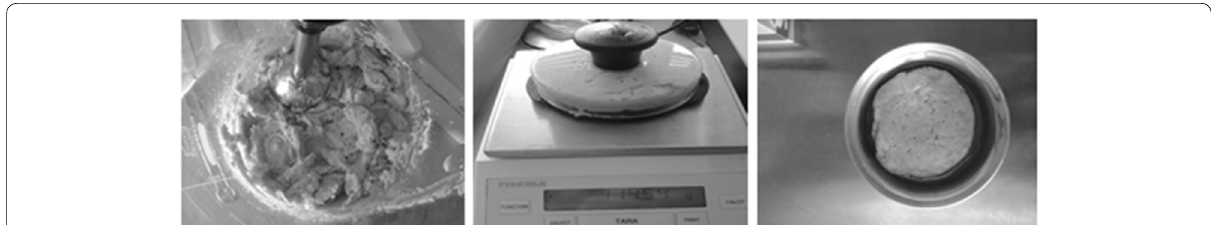
Fig. 3 Preparation of the fish patties ( left homogenizing the salmon filets, middle preparing the patties with a “burger press,” right fish patty in the aluminum pan before heating in the drying oven)